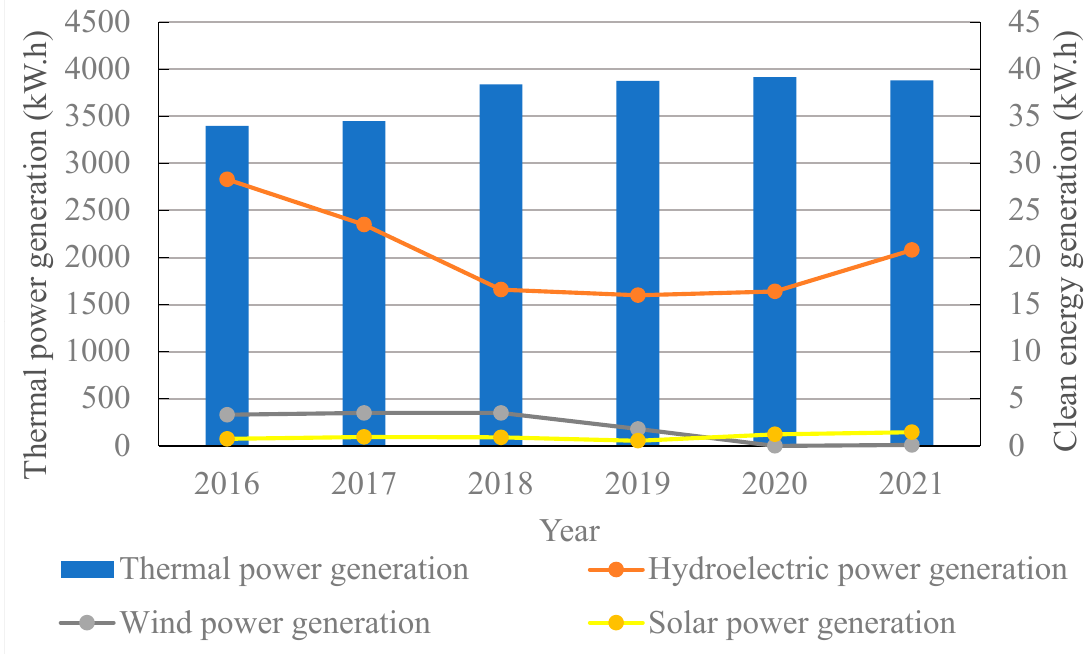
Figure 1. Power generation in the Beijing–Tianjin–Hebei region from 2016 to 2021.